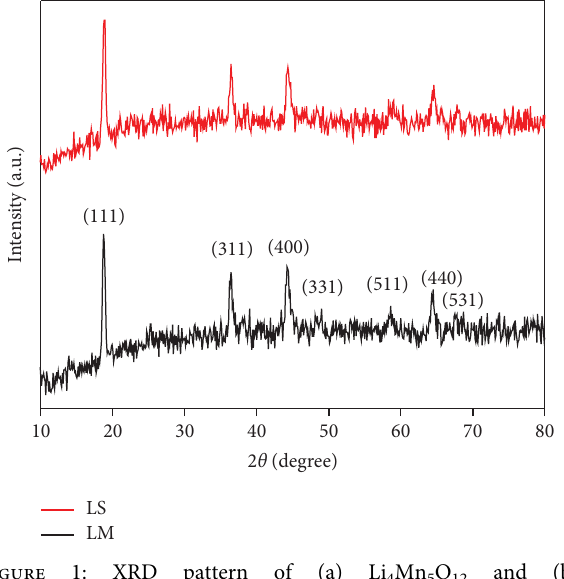
XRD pattern of (a) Li 4 Mn 5 O 12 and (b) Li 4 Mn 4.75 Sm 0.25 O 12